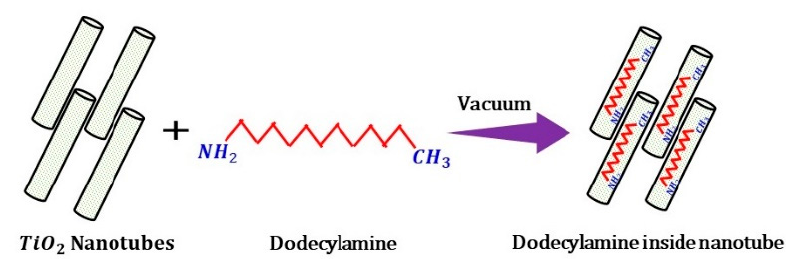
Figure 1. Schematic diagram showing the loading of dodecylamine (DOC) inside titanium oxide nanotubes (TNTs).